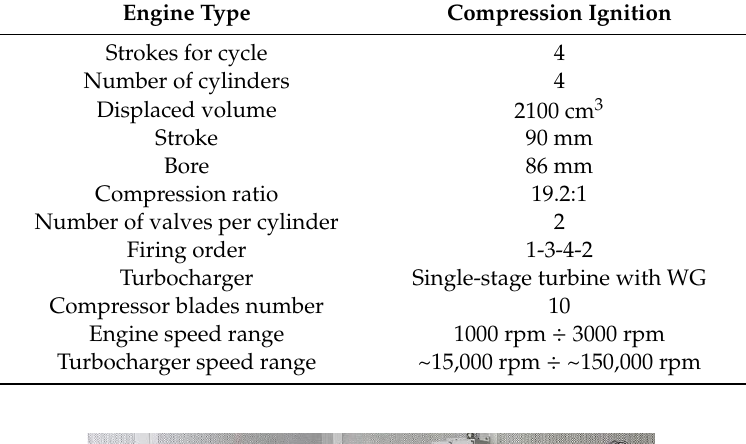
Table 2. Tested engine technical data.